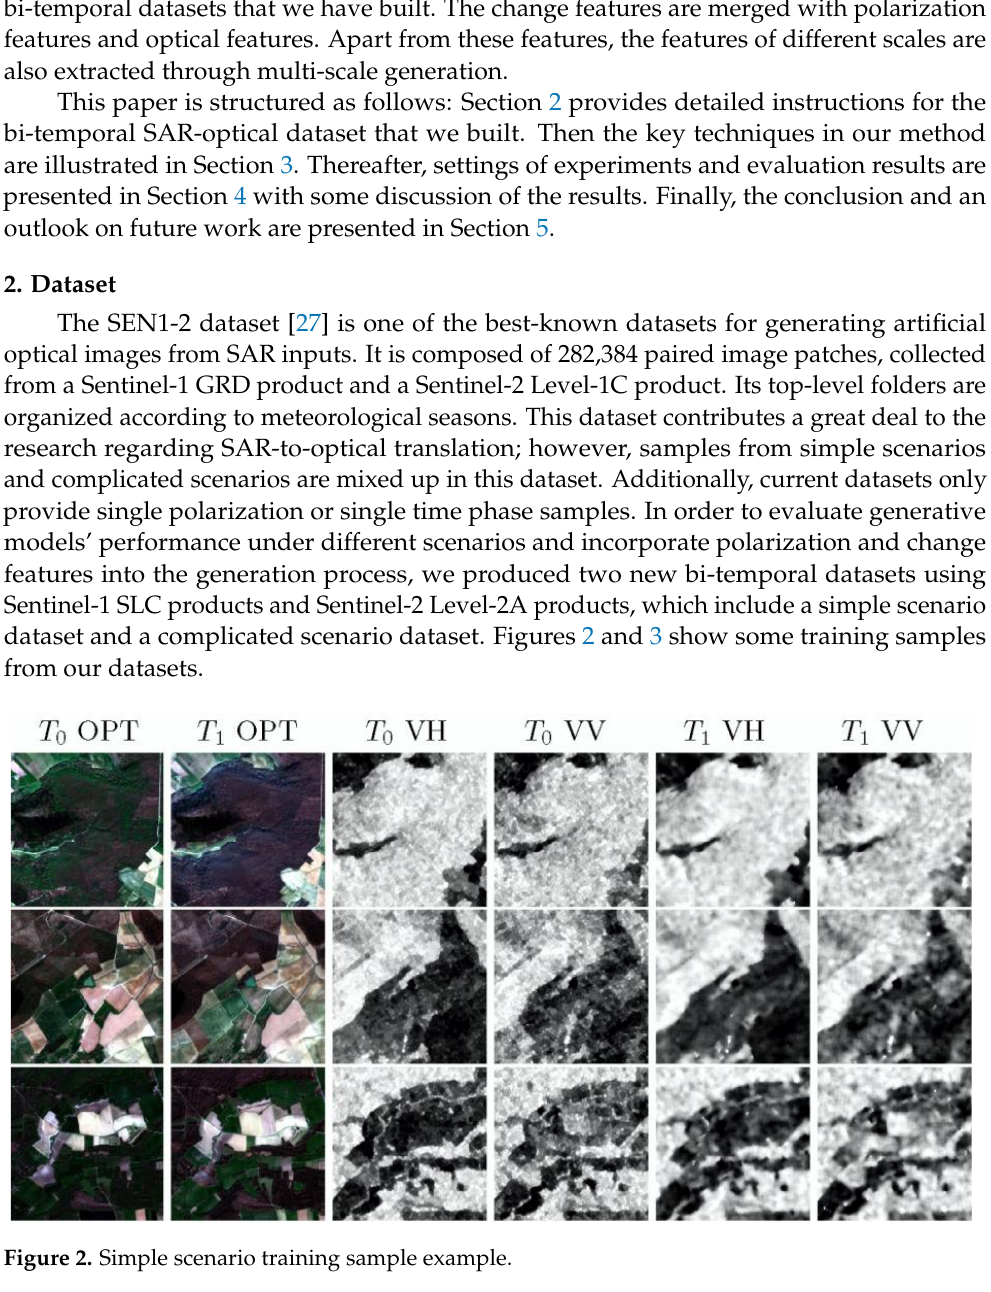
Figure 1. SAR-to-optical image synthesis using Pix2Pix [10] under simple and complicated scenar-